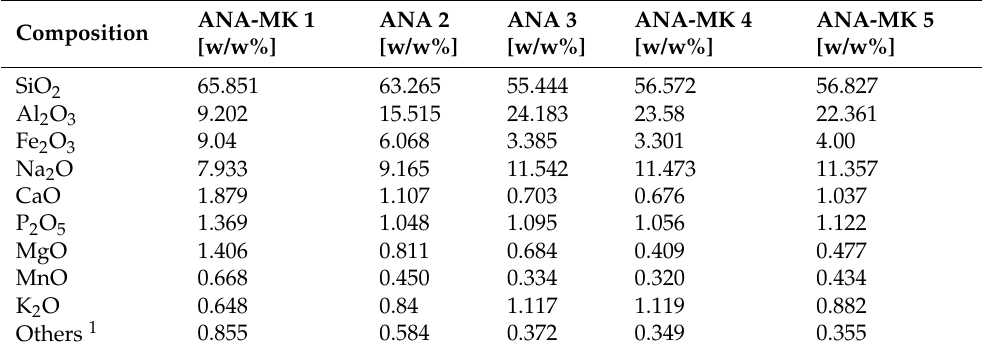
Table 5. Main chemical constituents (normalized values) of the adsorbents as determined by XRF.